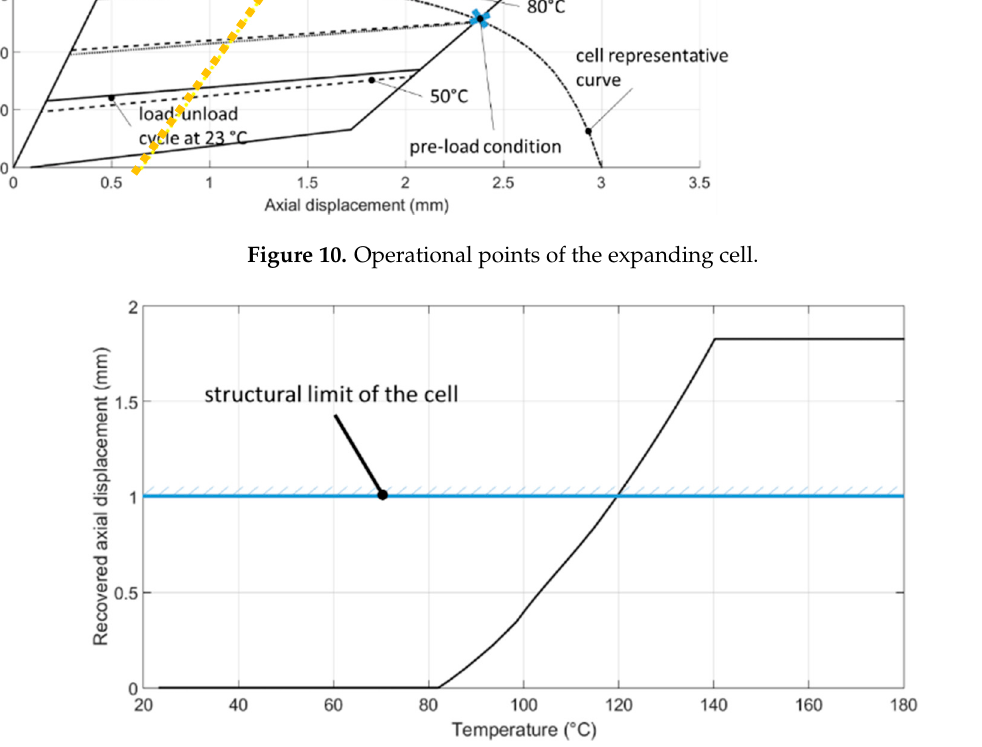
Figure 11. Axial displacement versus temperature.